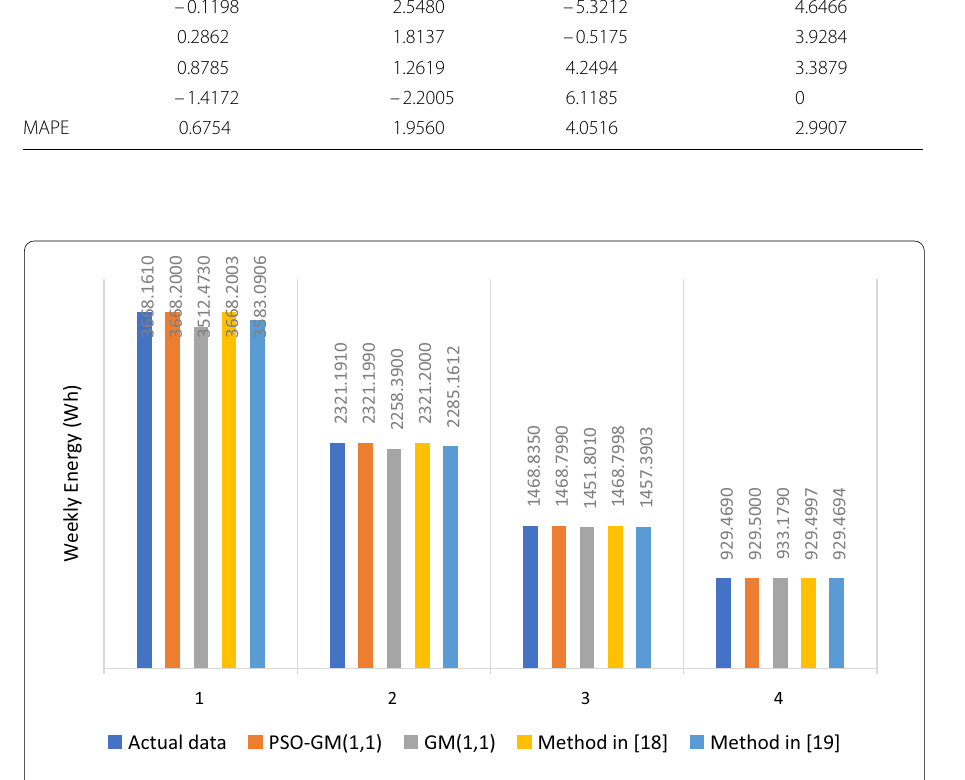
values determined by the PSO-GM(1,1) are the closest to the actuals. For example, for the energy consumption data of 450.031 for week 1, the PSO-GM(1,1) gave a value of 450.570 (with a minimal deviation of -0.539 while the GM(1,1) and the models in